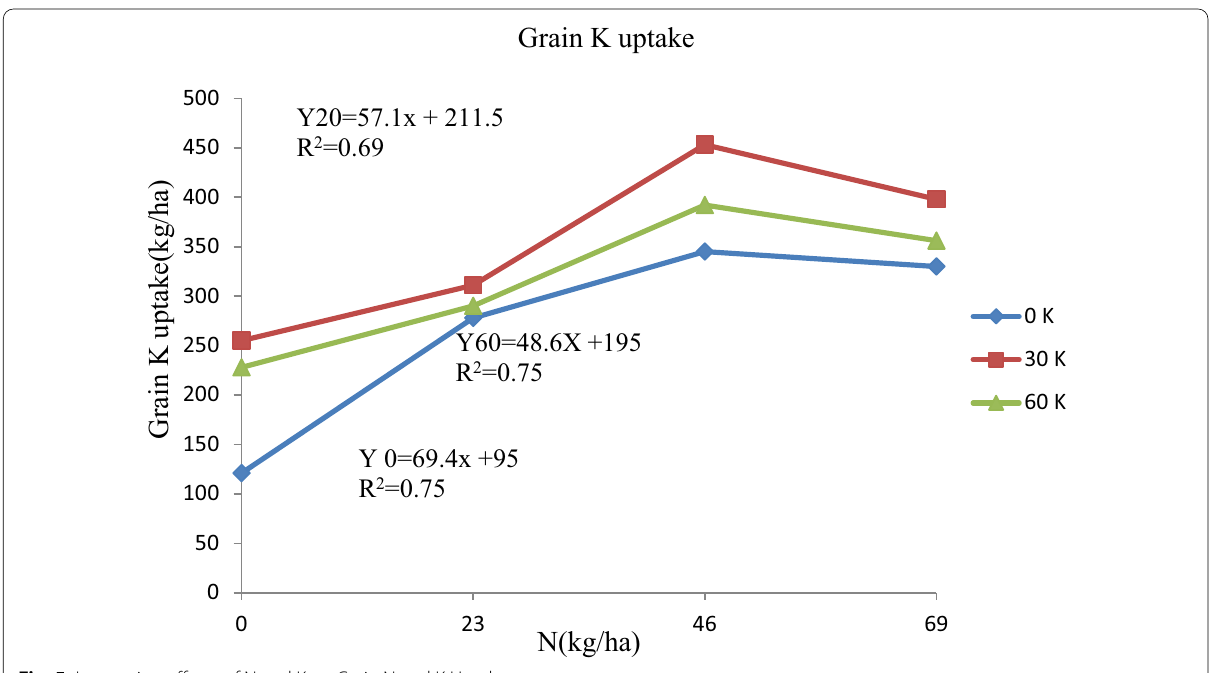
Fig. 5 Interaction effects of N and K on Grain N and K Uptake